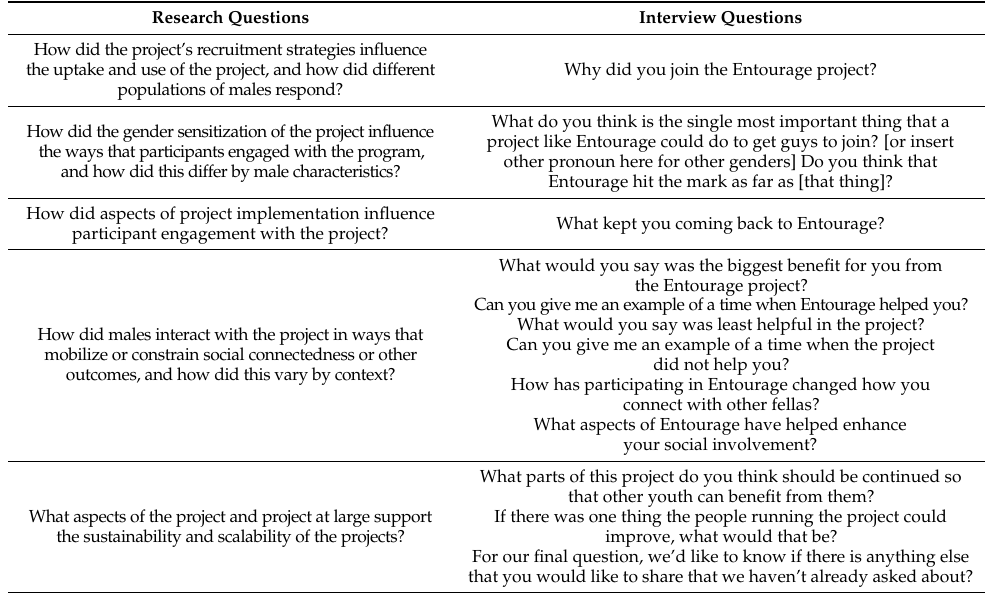
Table A3. Semi-Structured Interview Schedule and Guiding Research